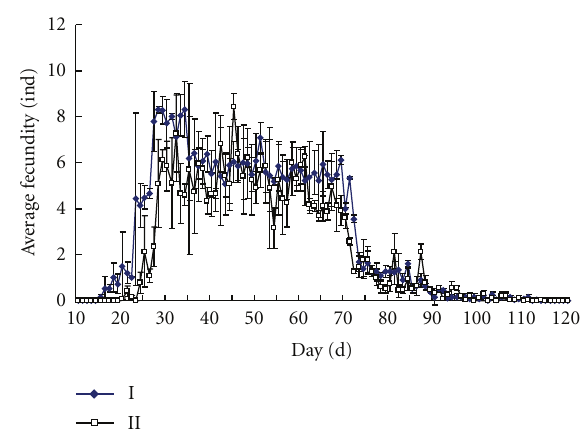
Figure 1: Oviposition lines of per female for two strains of B. dorsalis. I: Suscep tible strain, II: Trichlorphon slected strain.